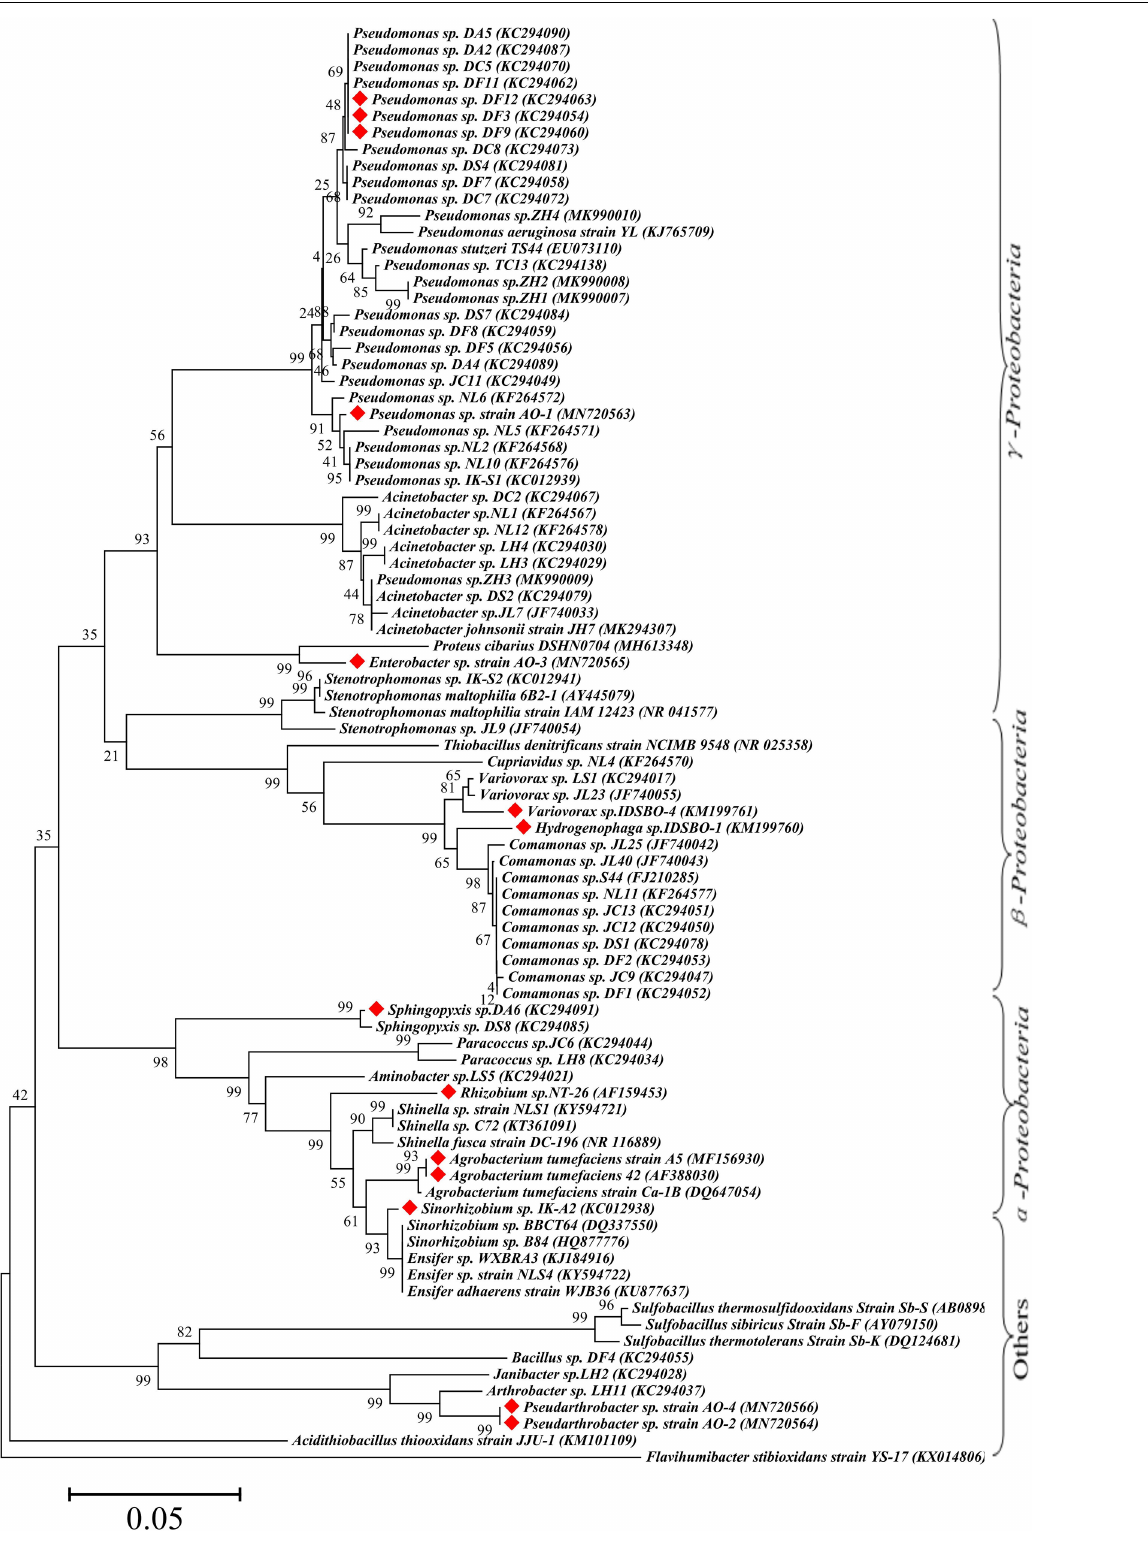
Frontiers in Microbiology |